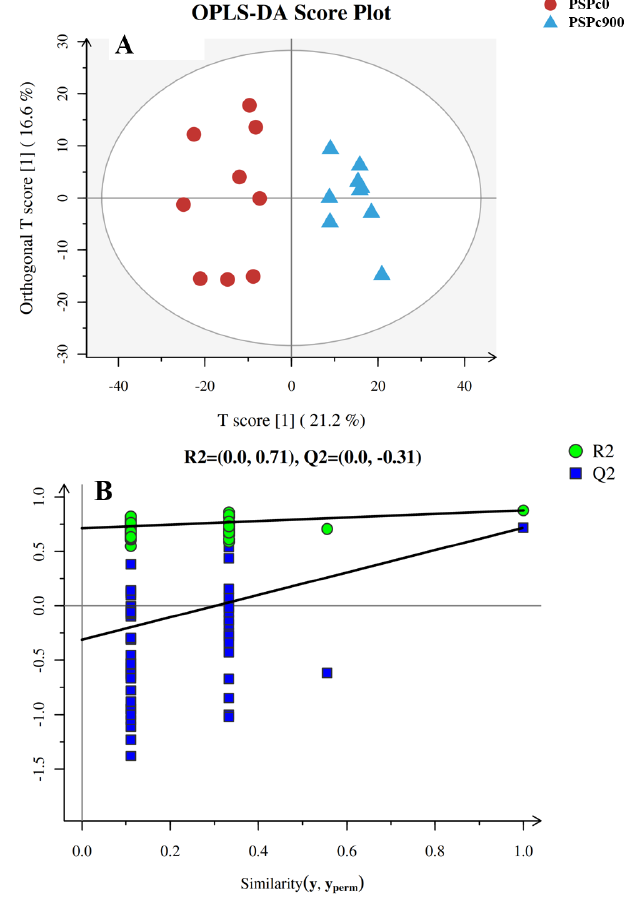
Figure 1. The score plots ( A ) and validation plots ( B ) of OPLS-DA from liver lipidomics profiles of juvenile American eels in the PSPc0 group and PSPc900 group. [1] in the image ( A ) means the first principal component.